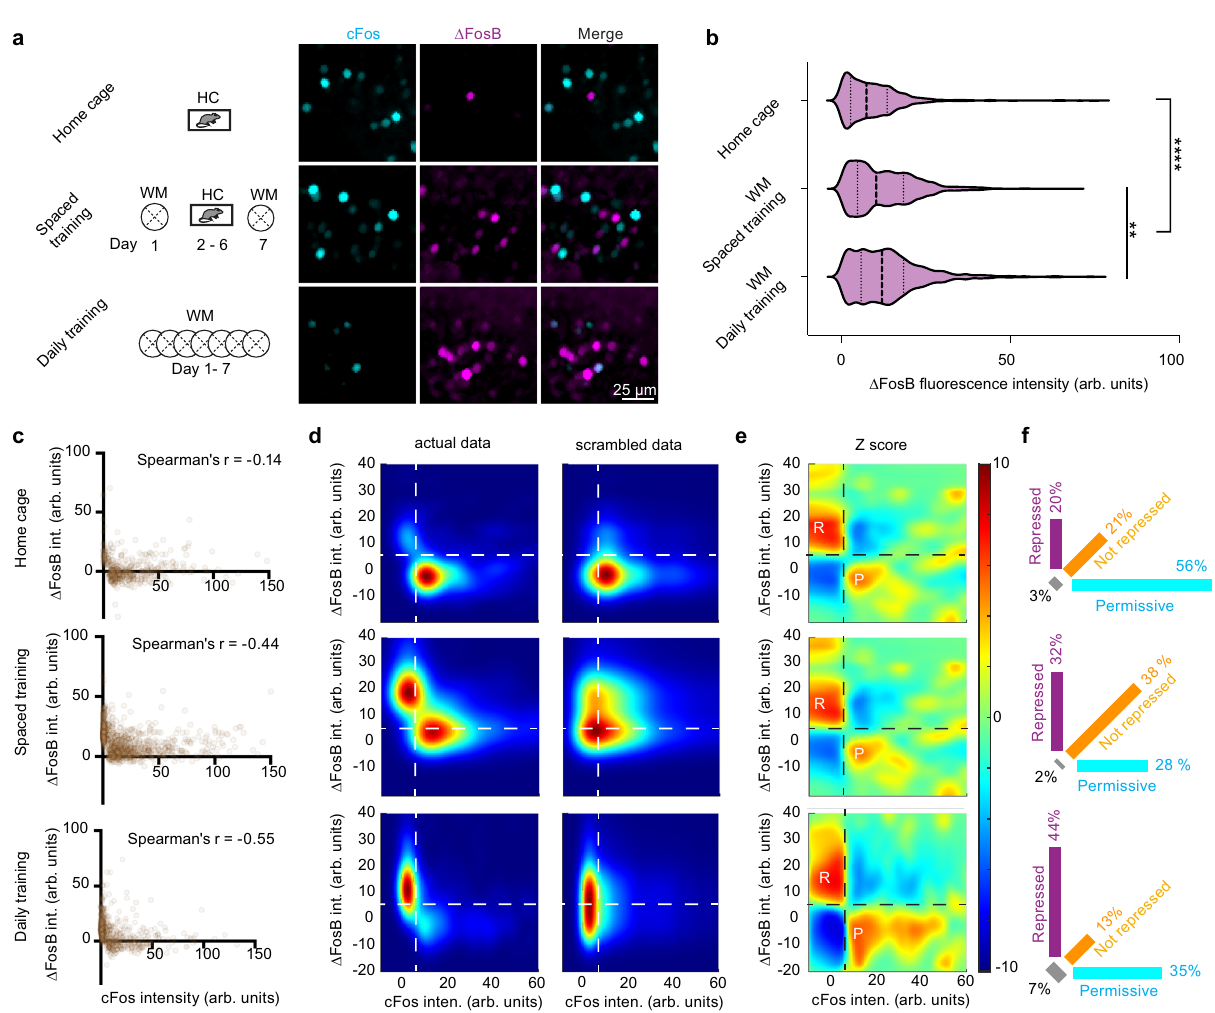
cFos inten. (arb. units) shEGFP (cFos) and Δ FosB expression in DG after the different training regimes (1 mouse each, see also Supplemental Fig. 11). WM training increased the strength of theinversecorrelationbetweencFosand Δ FosBexpression(Spearman ’ s r ). d Peak- scaled kernel density estimates of the data shown in c . Scrambled data is the average of 100 randomized combinations of the actual data. e Z-scores computed from d . Dashed lines are drawn between two regions of overrepresented cells (positive Z scores, red): Low cFos - high Δ FosB (R, repressed) and high cFos - low Δ FosB (P, permissive) and two underrepresented regions (blue). f Percentage of cells in the quadrants indicated in d and e . Magenta represents cells in the